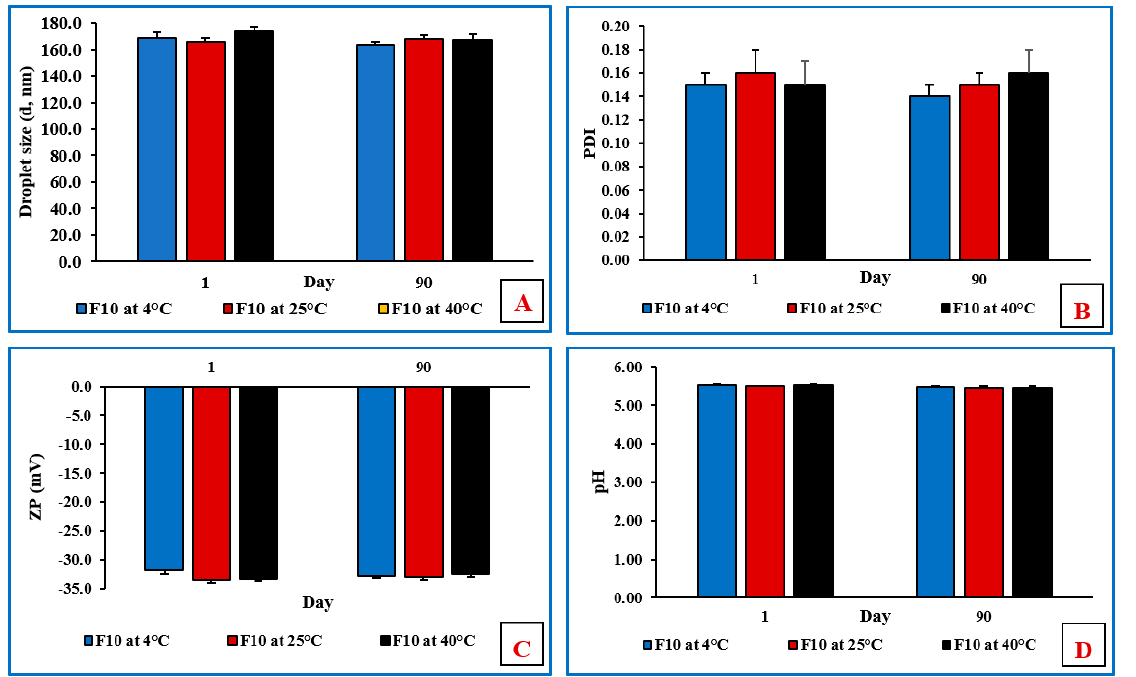
Figure 5. ( A ) Droplet size, ( B ) polydispersity index, ( C ) zeta potential, and ( D ) pH of F10 formulation over three months of storage at 4 °C, 25 °C, and 40 °C (mean ± SD, n =3).